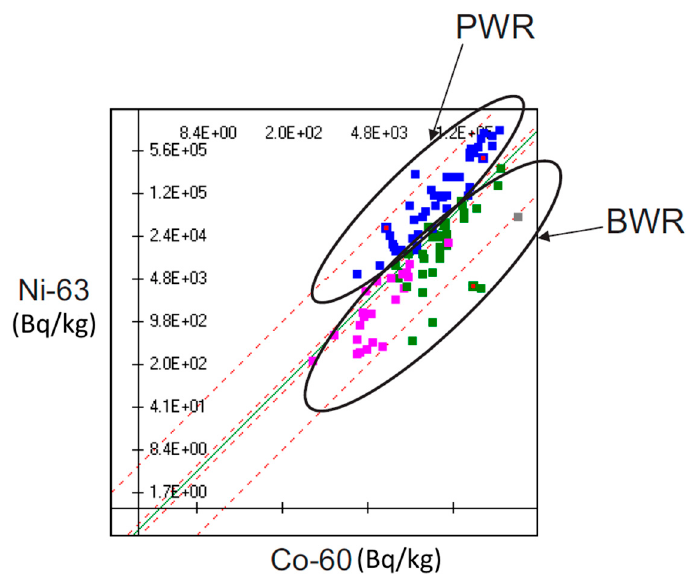
Figure 1. Ni-63~Co-60 correlation example for different reactor types: pressurized water reactor (PWR) and boiling water reactor (BWR). Adapted from Determination and Use of Scaling Factors for Waste Characterization in Nuclear Power Plants, © IAEA, 2009 [5].